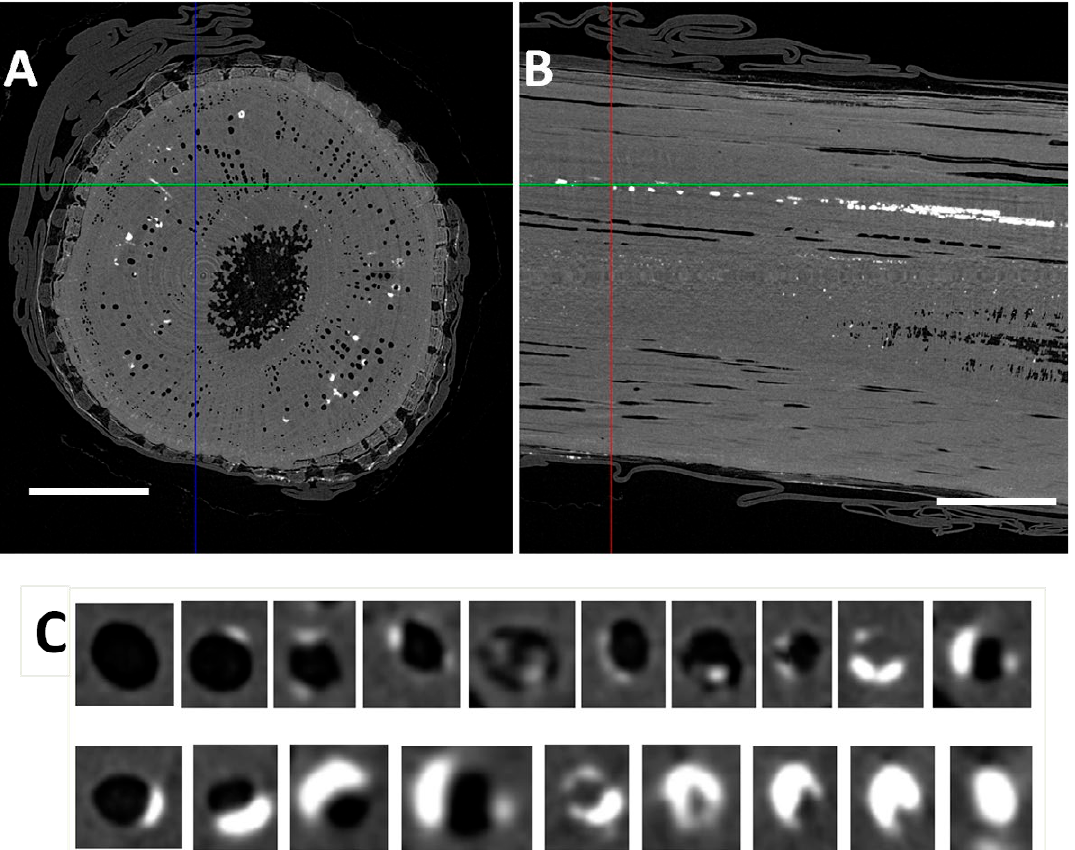
Figure 5. X-Ray microtomography (micro-CT) of a grapevine trunk (cv. Cabernet Sauvignon) infected by wood pathogens. (A) Cross- section showing some vessels partially or completely filled with gums. (B) Corresponding longitudinal section showing the accumulation of high-density material along the xylem vessels. (C) Individual xylem vessels with increasing gum accumulation in each from empty (top left) to filled (bottom right). Scale bars = 1 cm, resolution 6